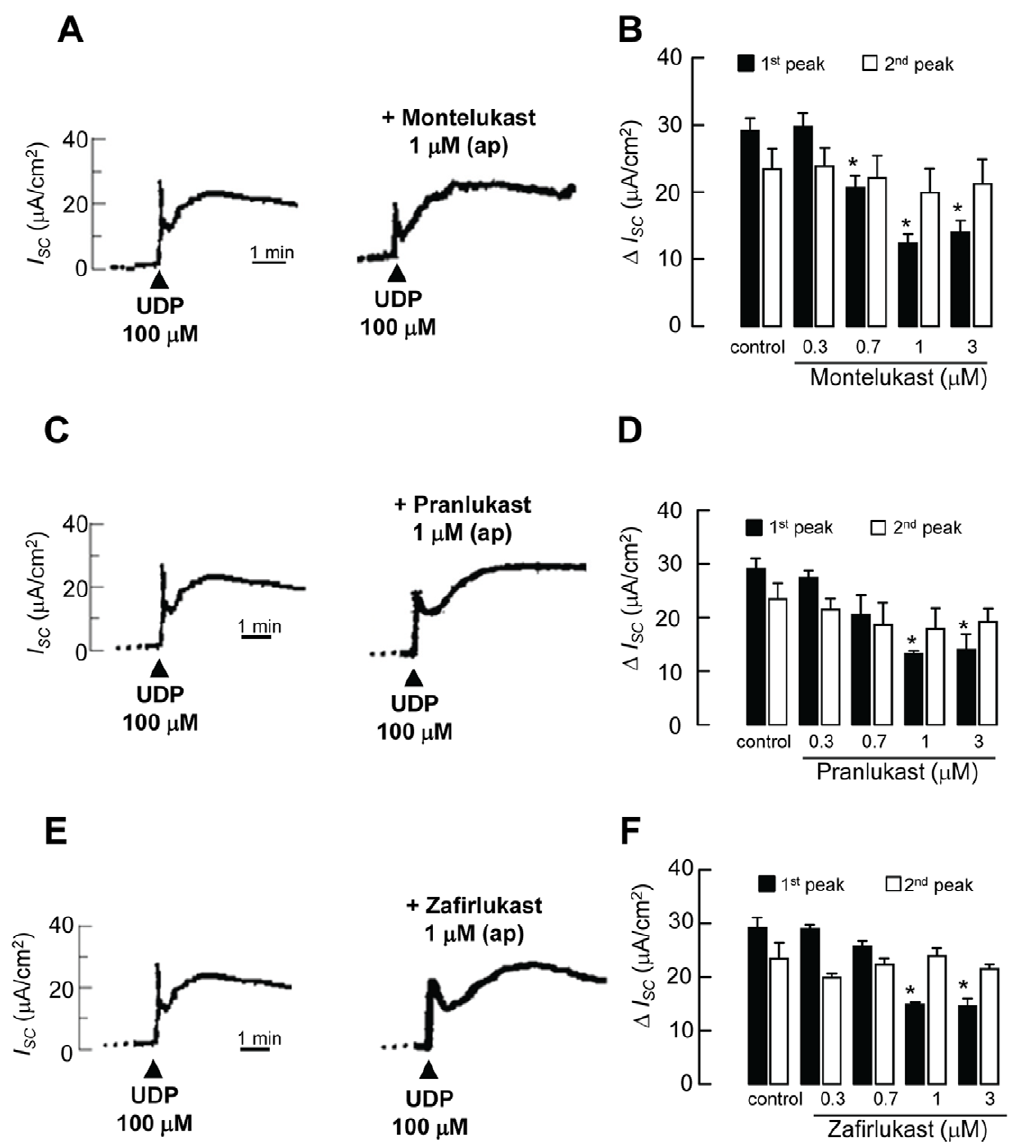
Figure 3. Effect of CysLT 1 receptor antagonists, montelukast, pranlukast, and zafirlukast, on UDP-evoked I SC responses. Representative recordings of I SC in response to the apical application of 100 m M UDP (shown by arrows) in the presence of montelukast (A). The CysLT 1 receptor antagonist was applied 10 min before the application of UDP (data not shown). Data are summarized for the inhibitory effects of montelukast (B) on the first and second peaks of I SC increases in response to UDP. Similar experiments were performed using pranlukast (C and D) or zafirlukast (E and F). The control was the apical application of UDP alone in the absence of any CysLT 1 receptor antagonist. Each column represents the mean 6 S.E. ( n =4–5). (*, p , 0.05, one-way ANOVA with Bonferroni post-hoc test compared with control). doi:10.1371/journal.pone.0022363.g003 zafirlukast (Fig. 3E). The UDP-induced first I SC peak was significantly inhibited by apical pretreatment of the epithelia with 1 and 3 m M pranlukast (Fig. 3D) or zafirlukast (Fig. 3F). Again, the UDP-induced second I SC peak was not inhibited by the apical application of pranlukast or zafirlukast. For the highest concen- tration of CysLT 1 receptor antagonists tested (3 m M), approxi- mately 50% of the UDP-evoked first peak of I SC was inhibited. All three CysLT 1 receptor antagonists failed to inhibit the apical UDP-evoked I SC (first and second peaks) when applied to the basolateral aspect of the epithelia (data not shown). Similar experiments were conducted using a P2Y 2 /P2Y 4 agonist, UTP (100 m M). Interestingly, all three CysLT 1 receptor antagonists